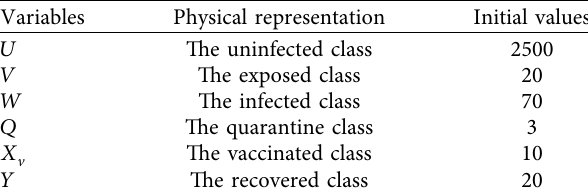
Figure 1: Compartment diagram of COVID–19. Table 1: Te compartments and their description involved in model (1) with initial values.